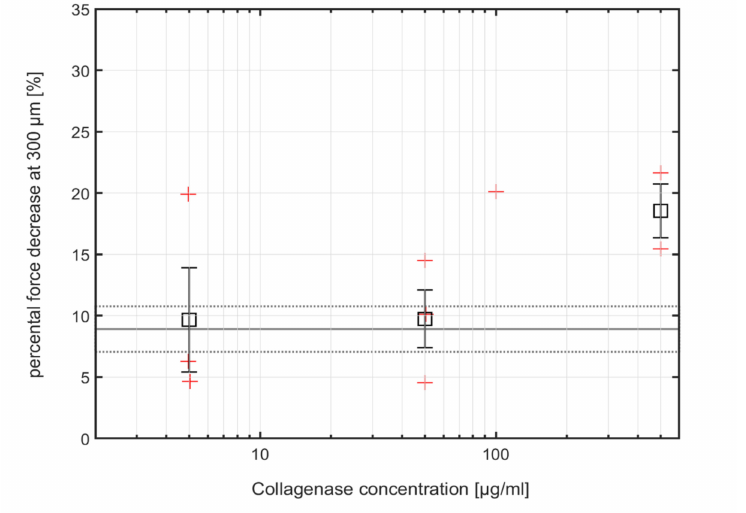
Figure 3. Percentage force di ff erences at di ff erent collagenase concentrations in µ g / mL and means of the results measured with the FBG micro-indenter. The grey solid line indicates the mean for the data measured on the native cartilage (concentration 0 µ g / mL) which is not displayed, and the grey dotted lines indicate the standard error of this mean. The red crosses indicate individual measurements and the black squares are the corresponding mean values with error bars indicating the standard error of the means. At the concentration of 100 µ g / mL, only one data set (FGB and IT-AFM) is available, therefore no mean value and standard error were calculated for this concentration. The p -values of a one-way unbalanced ANOVA test against native sample variation for 5, 50, and 500 µ g / mL are 0.87, 0.79, and 0.06,